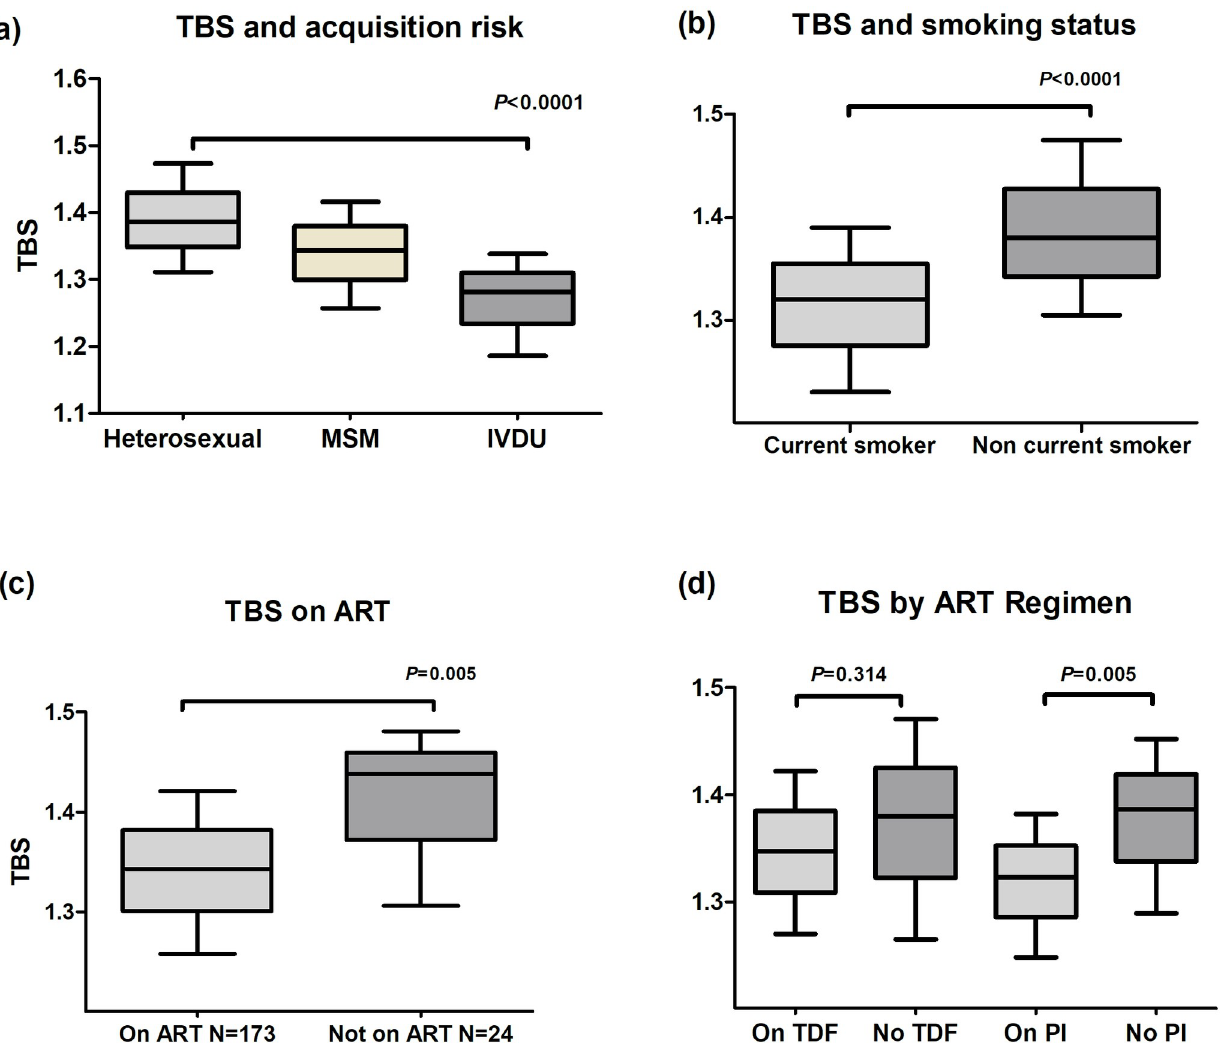
Fig 2. Median TBS according to (a). HIV acquisition risk, (b). Smoking status, (c). ART exposure and (d). TDF or PI exposure. TBS- Trabecular bone score, MSM—Men who have sex with men, IVDU—Intravenous drug user, ART—Antiretroviral therapy, TDF—Tenofovir disproxil fumarate, PI—Protease